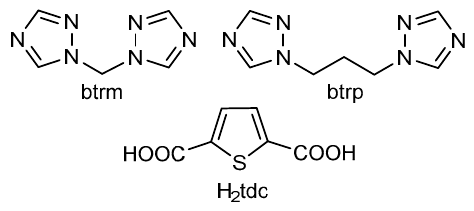
Figure 1. Bis(1,2,4-triazol-1-yl)methane, 1,3-bis(1,2,4-triazol-1-yl)propane and 2,5-thiophenedicarboxylic acid ligands used in this work for the preparation of coordination